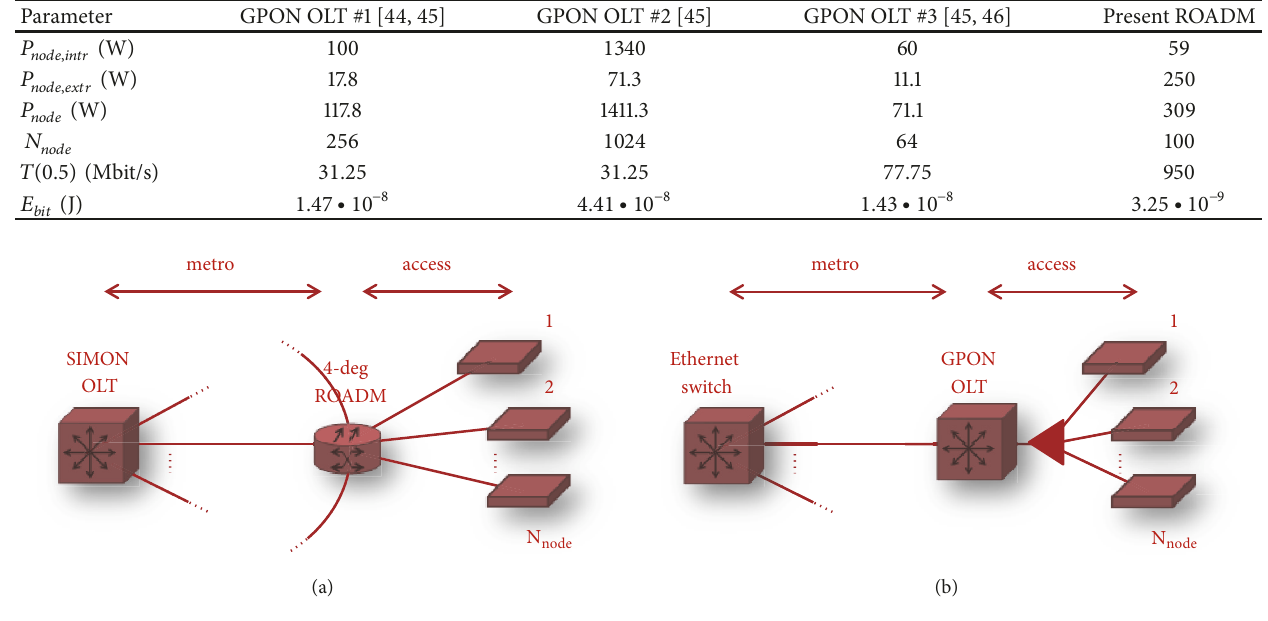
Figure 10: Compared (a) proposed SDN-like Innovative Metro-Access Optical Network (SIMON) and (b) metro/access conventional